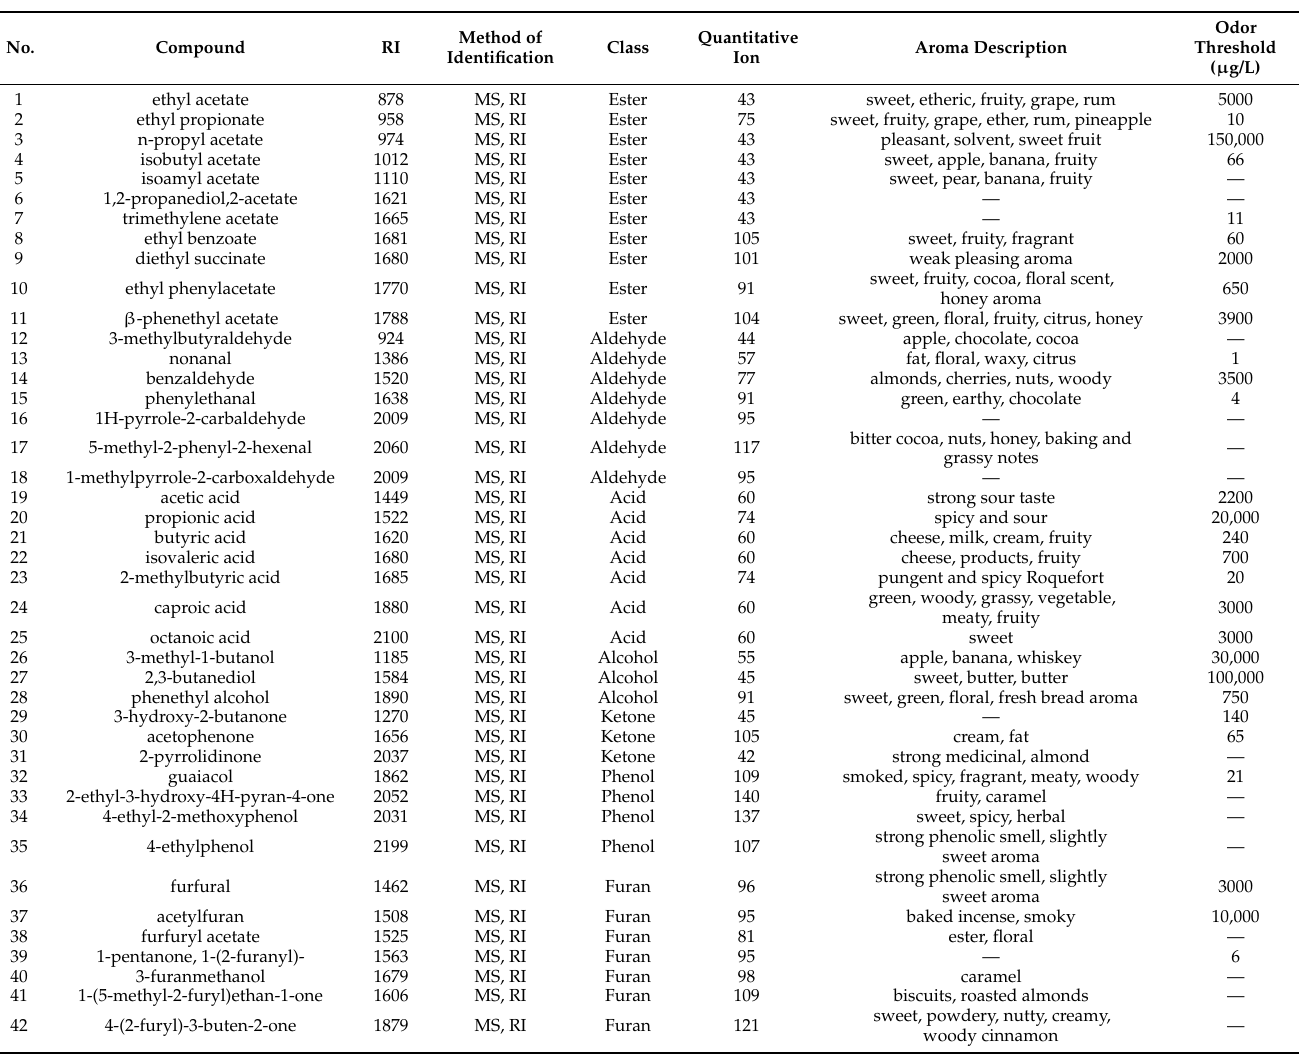
Table 2. Relevant information of gas chromatography–mass spectrometry (GC–MS) analysis on vinegar